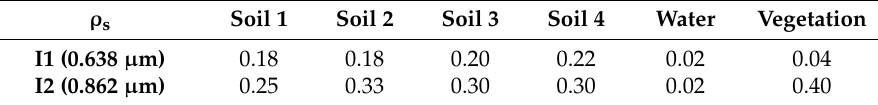
Table 1. Surface reflectance information of five types of land